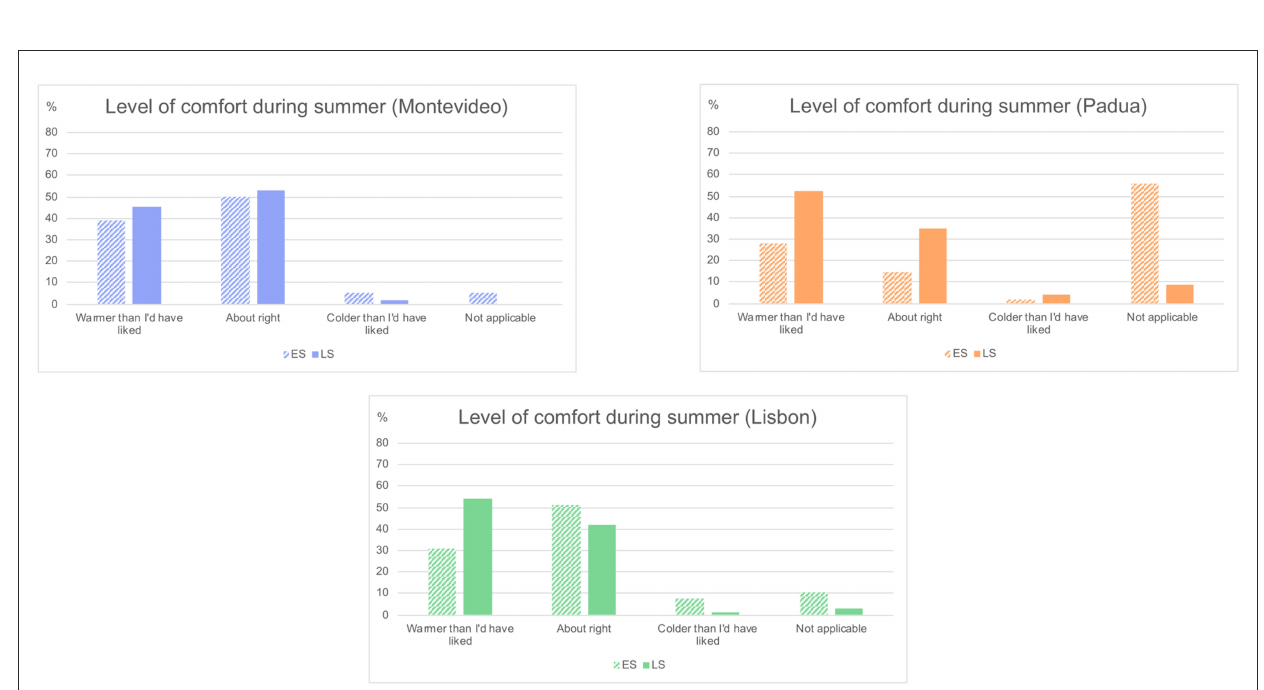
FIGURE4 Perception of energy comfort during summer of ES and LS of Montevideo, Lisbon, and